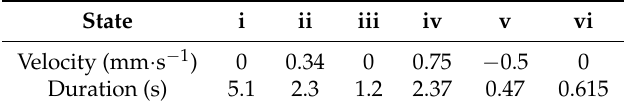
Figure 5. Measured distance signal (black) and reconstruction by the basic SSA filter (red) and the moving averaging (green dot). ( a ) Entire measured distance signal; ( b – f ) partial views of the measured distance at motion state boundaries. Table 2. Measured distance signal states of motion, corresponding to Figure